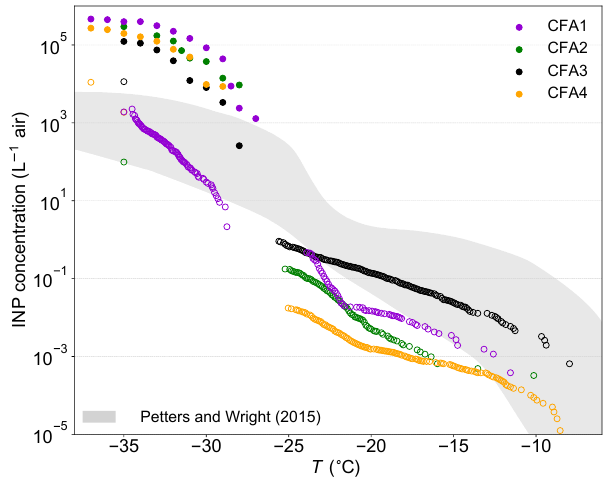
Figure 6. Estimated INP concentrations ∼ 80km downstream of a coal-fired power plant based on size distributions measured in a plume by Parungo et al. (1978). Full circles represent dry particle generation, open circles wet particle generation and cold-stage mea- surements. The shaded area indicates typical atmospheric INP con- centrations derived from precipitation samples (Petters and Wright,